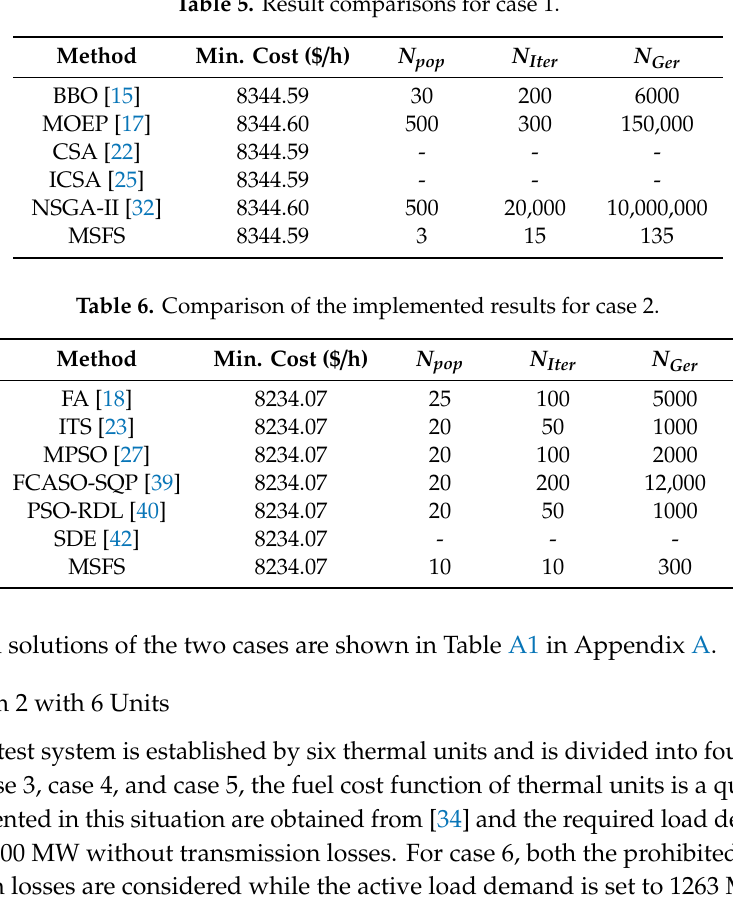
Table 5. Result comparisons for case 1.